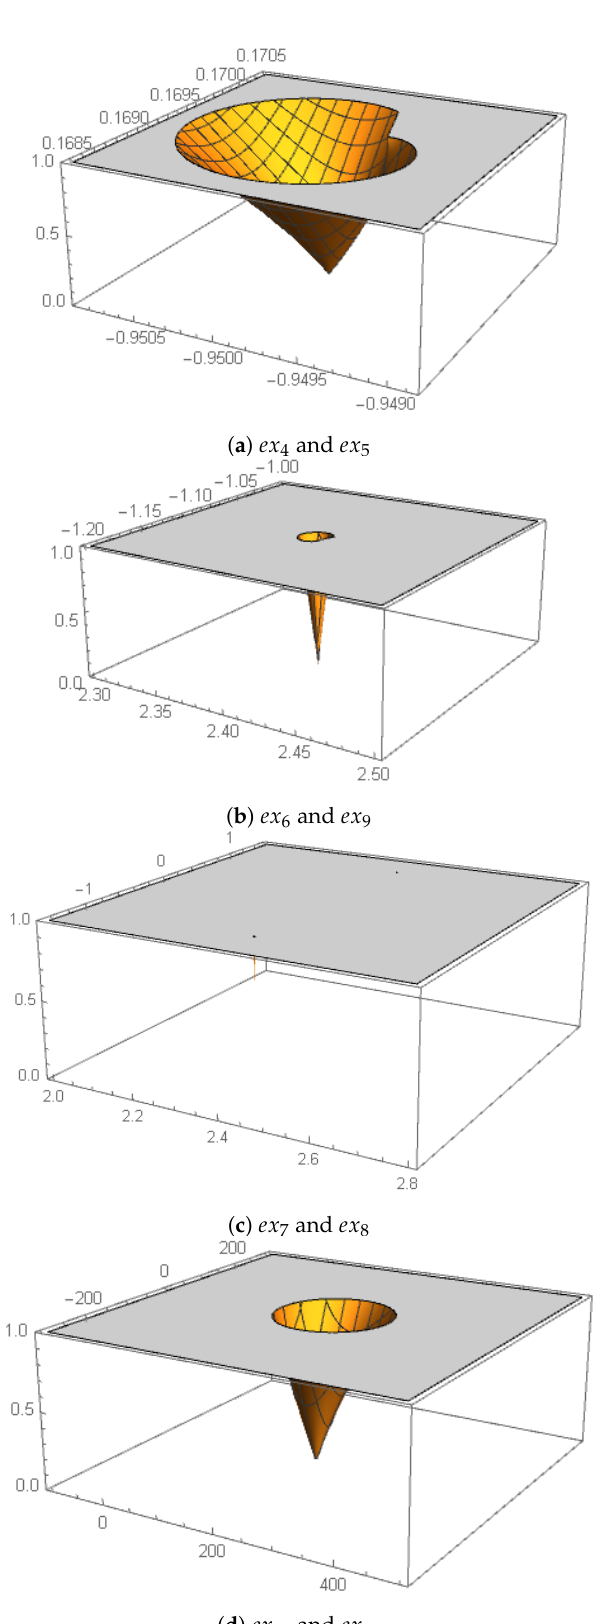
Figure 2. Stability surfaces of 8 strange fixed points (in gray color, the complex area where each fixed point is repulsive, being attracting in the